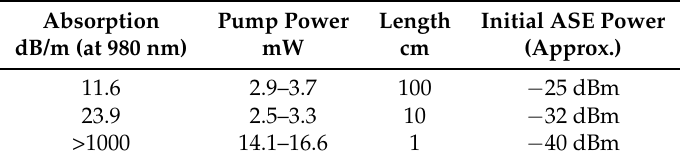
Table 1. A comparison of the optimal parameters (pump power and length) for three fibres with different pump absorption: Er Fibrecore I-12 (11.6 dB/m), Er Fibrecore I-25 (23.9 dB/m), and in-house fabricated Er/Yb (>1000 dB/m).